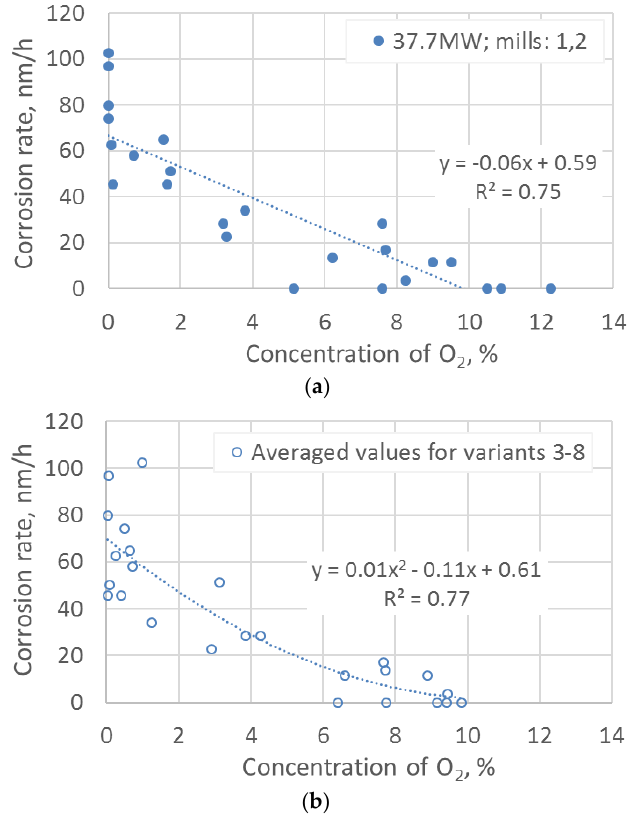
Figure 11. Correlation of the oxygen concentration measurement results in the boundary layer of the evaporator with the average corrosion rate determined from ultrasonic measurements: ( a ) one selected boiler operation option (Variant No.3), ( b ) averaged values for six boiler operation variants (Variants No. 3 – 8).